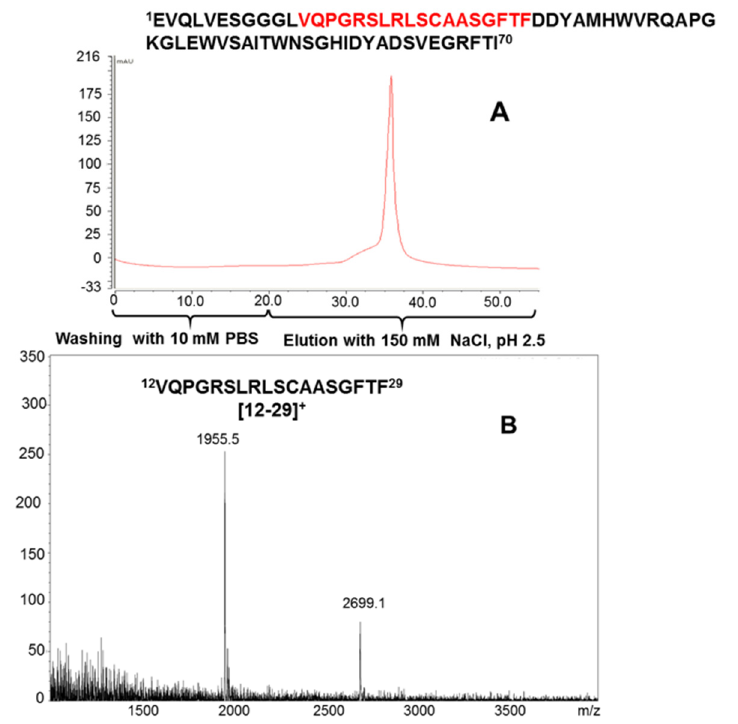
Figure 4. Elution of α -chymotryptic digest mixture of Adalimumab from immobilized serum ( A